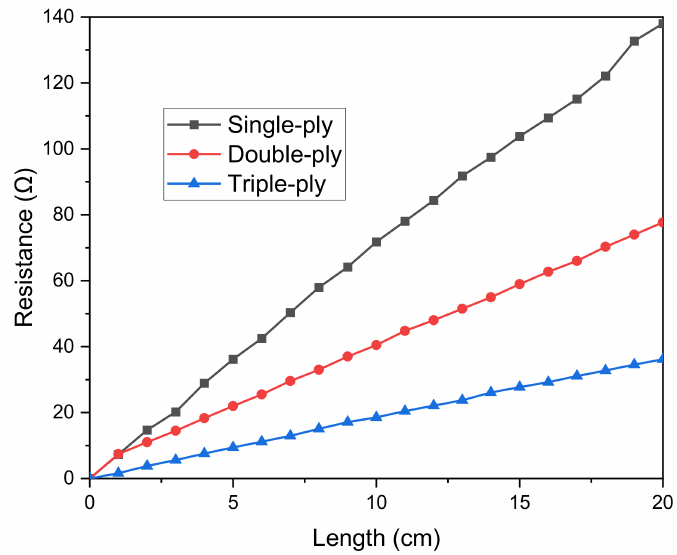
Figure 2. Effect of single-ply, double-ply, and triple-ply thread length on the resistance